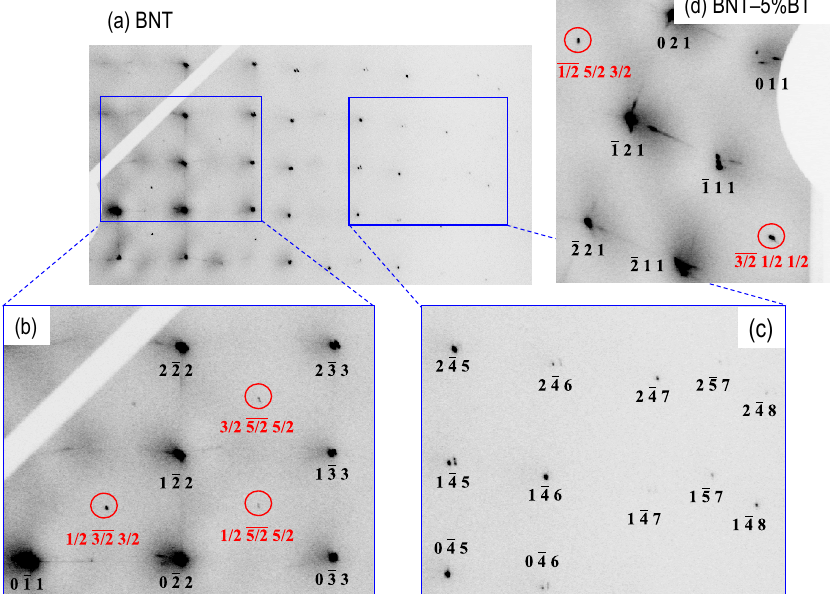
Figure 2. Synchrotron radiation X-ray diffraction (SR-XRD) patterns at E observed for the single crystals of ( a – c ) BNT and ( d ) BNT–5%BT. ( b ) and ( c ) indicate the expansions of the square parts in ( a ). The superlattice 1/2 ( o o o ) reflections ( o : odd) in addition to the fundamental hkl reflections from the ABO for both crystals.